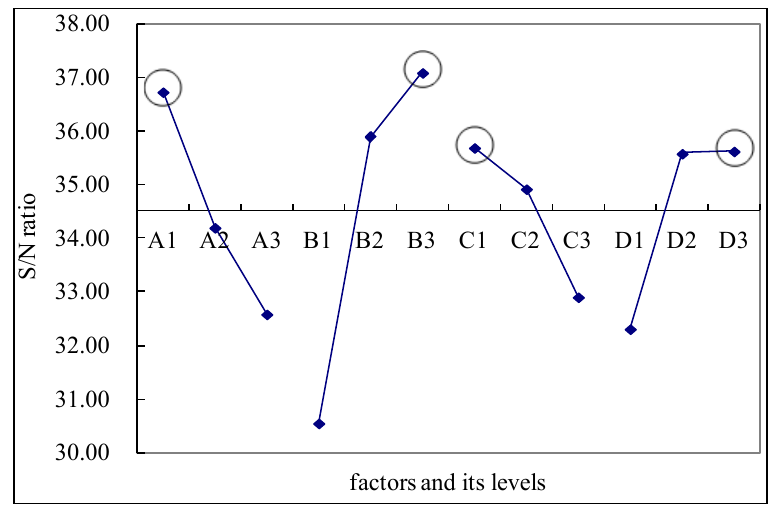
Figure 2. Response graph of higher-the-better signal-to-noise ratios for fatty acid methyl aster (FAME) contents at different conditions (A, temperature; B, pressure; C, flow rate; D, Retention